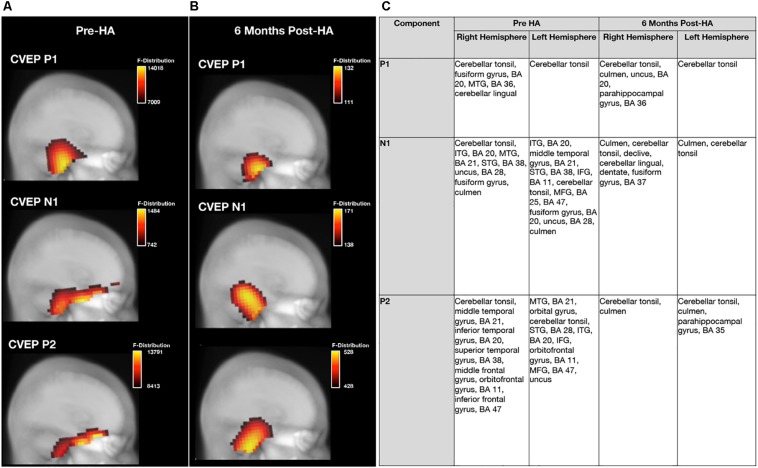
Effects of treatment with hearing aids on cortical source activation patterns elicited by visual motion stimuli in age-related hearing loss. (A) Depicts current density source reconstructions (CDR) for the P1, N1, and P2 cortical visual evoked potential (CVEP) components for the group of adults with untreated age-related hearing loss assessed at baseline prior to hearing aid fitting (pre-HA) (n = 28) and (B) depicts average CDRs for the P1, N1, and P2 CVEP components in a sub-group of these adults (n = 21) assessed post-treatment after 6 months of hearing aid use (post-HA). 3D current density source reconstructions obtained via standardized low-resolution brain electromagnetic tomography (sLORETA) are projected on a 2D depth-buffered structural magnetic resonance image (Maximum Intensity Projection), providing visualization of the voxels with the highest likelihood of activation. The color scale to the right of each figure indicates the statistical likelihood of activation (F-statistic), from lowest (red) to highest (yellow) probable current density. (C) Describes regions of cortical source activity for each CVEP component, including Brodmann areas (BA), for the age-related hearing loss group at baseline and 6-month follow-up by rank in order highest to lowest likelihood of activation (F-statistic).